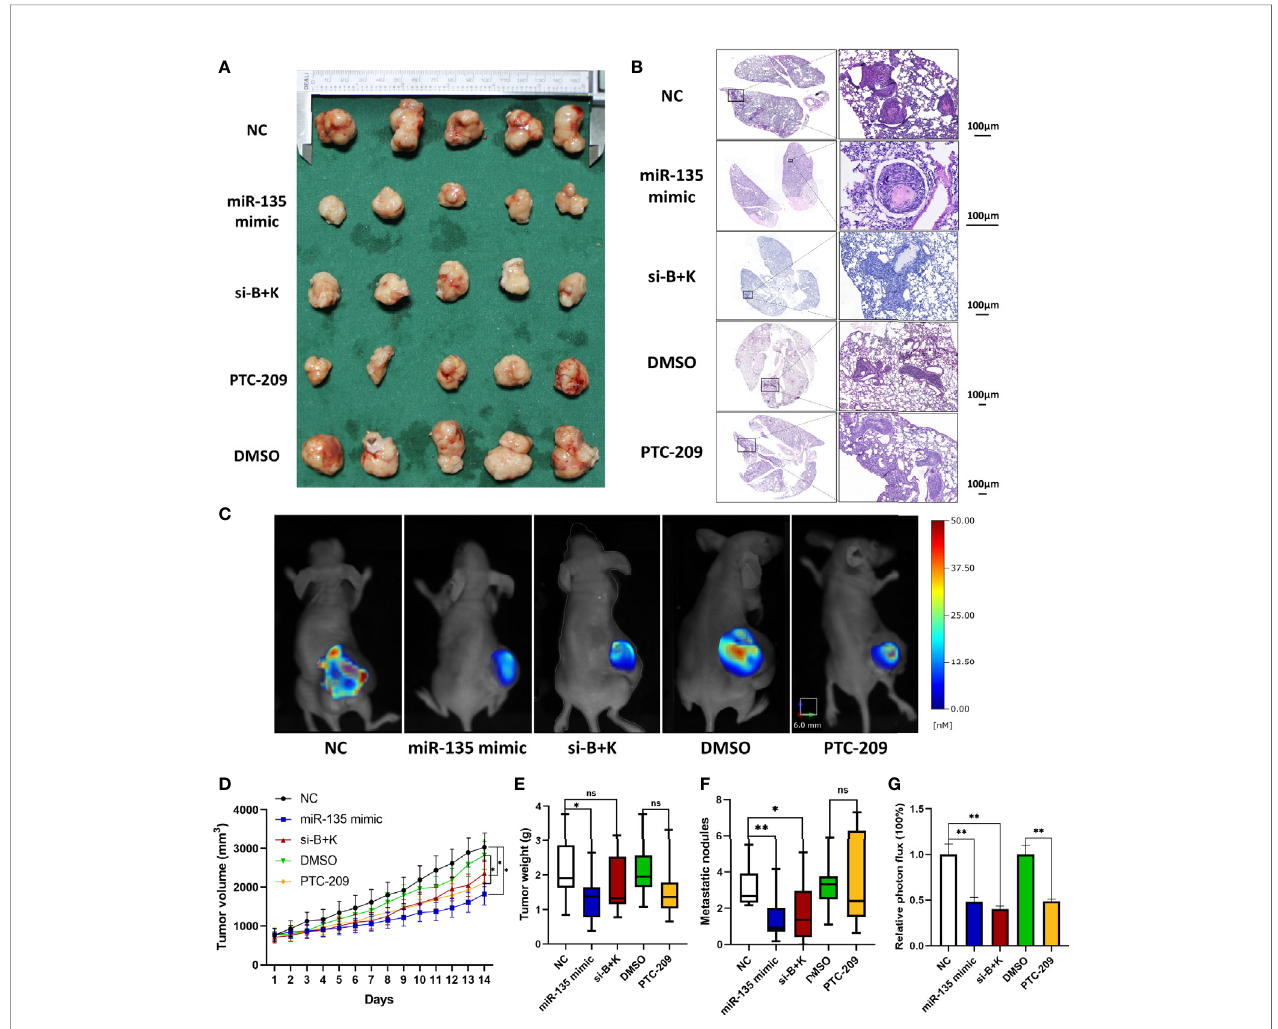
FIGURE 3 | miR-135a, combination therapy, and PTC-209 suppression of mouse OS cell xenograft growth; miR-135a and combination therapy suppression of lung metastasis in vivo . (A) Xenograft photographs. Saos-2 cells were grown and injected into nude mice, and then treat mice with miR-135 mimic, si-B+K, negative control, PTC-209, and DMSO respectively. After 2 weeks, the mice were sacri fi ced and the xenografts were photographed. (B) HE staining of mouse lung tissues. The mice were sacri fi ced and the lungs were resected and subjected to tissue processing, embedding, sectioning, and HE staining to quantify tumor cell lung metastasis. Scale bar, 100 m m. (C) Bioimages. Before sacri fi ced, mice were subjected to bioimaging of the MMPs activity in xenograft tumors with the fl uorescence molecular tomography using MMPSense 680. (D) Growth curves of mouse OS cell xenografts. (* p < 0.05; ** p < 0.01; n = 10). The signi fi cance of differences among groups were analyzed by ANOVA test and the effects were corrected using the Greenhouse – Geisser method in tumor volume because the data did not meet the hypothesis of sphericity (Mauchly ’ s test statistic W=0.000, p < 0.001). (E) Weight of mouse OS cell xenografts. (* p < 0.05; ns p >0.05; n = 10). (F) The graph of the quanti fi ed data of metastatic nodules. (ns p > 0.05; * p < 0.05; ** p < 0.01; n = 10). (G) The graph of the quanti fi ed data of MMPs activity in xenograft tumors. (** p < 0.01; n = 5). ns, not signi fi